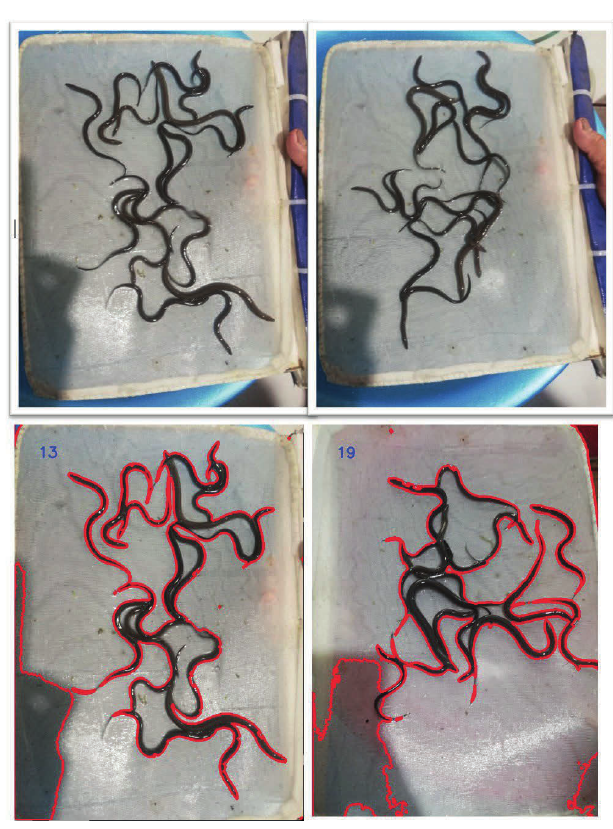
Fig. 11. An illustration of eels counting with images captured without using a photo box.